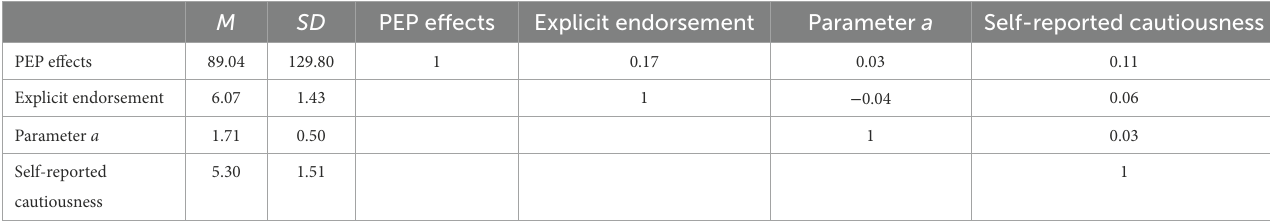
TABLE 2 Correlations between implicit and explicit endorsement of cautiousness-related stereotypes in the relevant context and cautious behavior for the older group. M SD